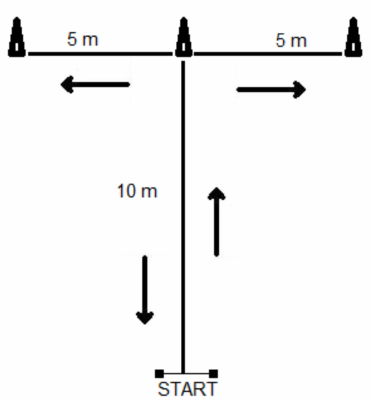
Figure 2. The layout of the T-Test of Agility modified from Semenick